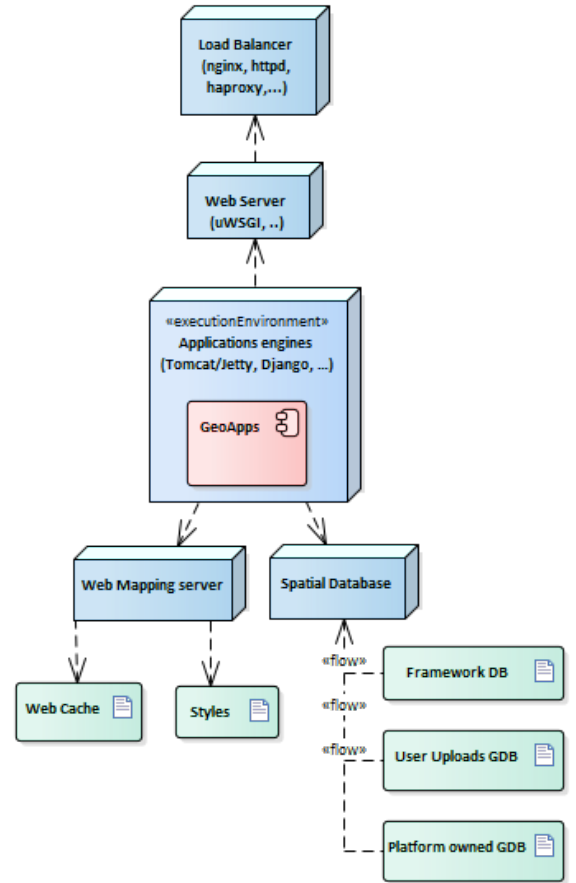
Figure 2 . Location Intelligence platform components.